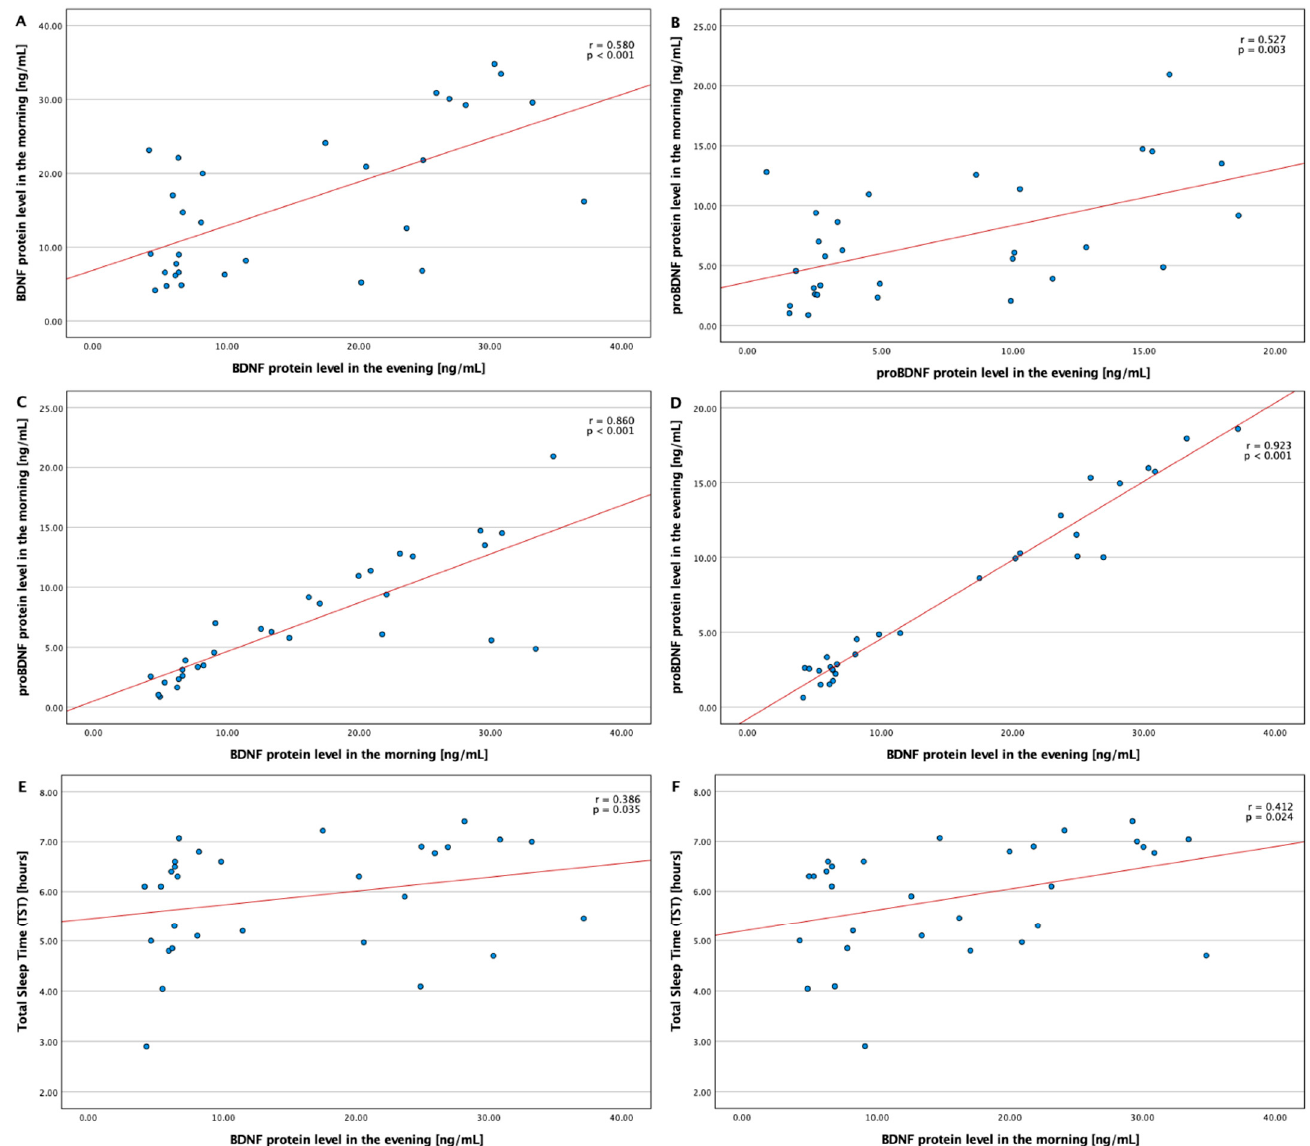
Figure 2. Correlations between BDNF and proBDNF protein levels and chosen parameters BDNF— brain-derived neurotrophic factor; proBDNF—premature brain-derived neurotrophic factor; TST— total sleep time. ( A )—Correlation between BDNF protein level in the morning and BDNF protein level in the evening. ( B )—Correlation between proBDNF protein level in the morning and proBDNF protein level in the evening. ( C )—Correlation between proBDNF protein level in the morning and BDNF protein level in the morning. ( D )—Correlation between proBDNF protein level in the evening and BDNF protein level in the evening. ( E )—Correlation between total sleep time and BDNF protein level in the evening. ( F )—Correlation between total sleep time and BDNF protein level in the morning.